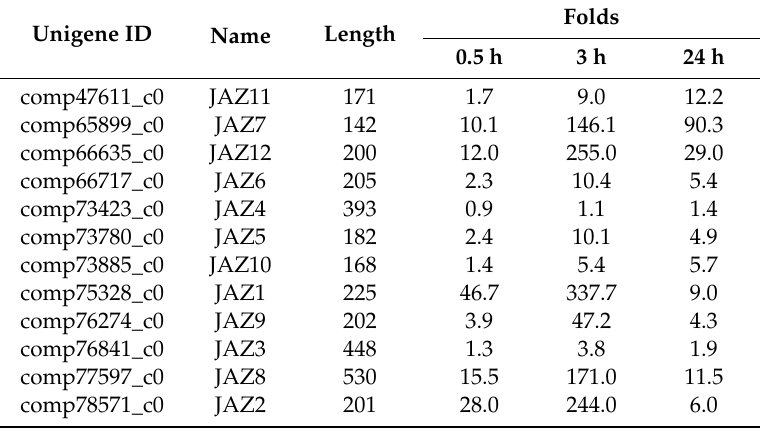
Table 2. List of full-length JAZ genes isolated from Taxus